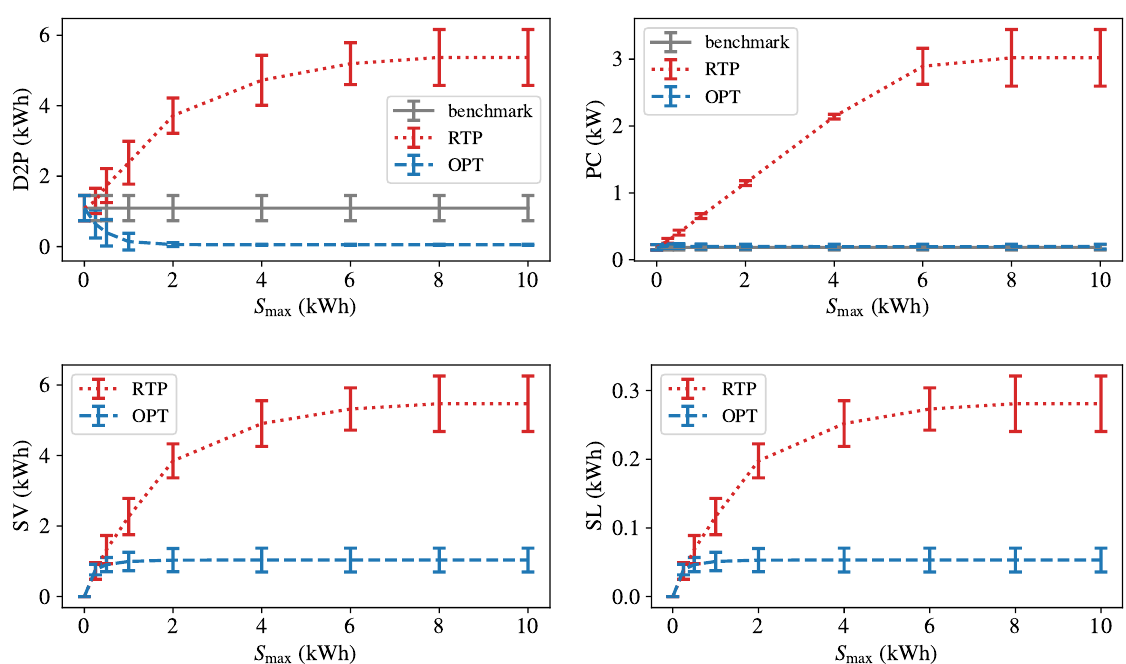
Figure 5. Mean and standard deviation values of the indicators D2P, PC, SV, and SL, see (15) to (18), over all days for different ESS capacities S max .